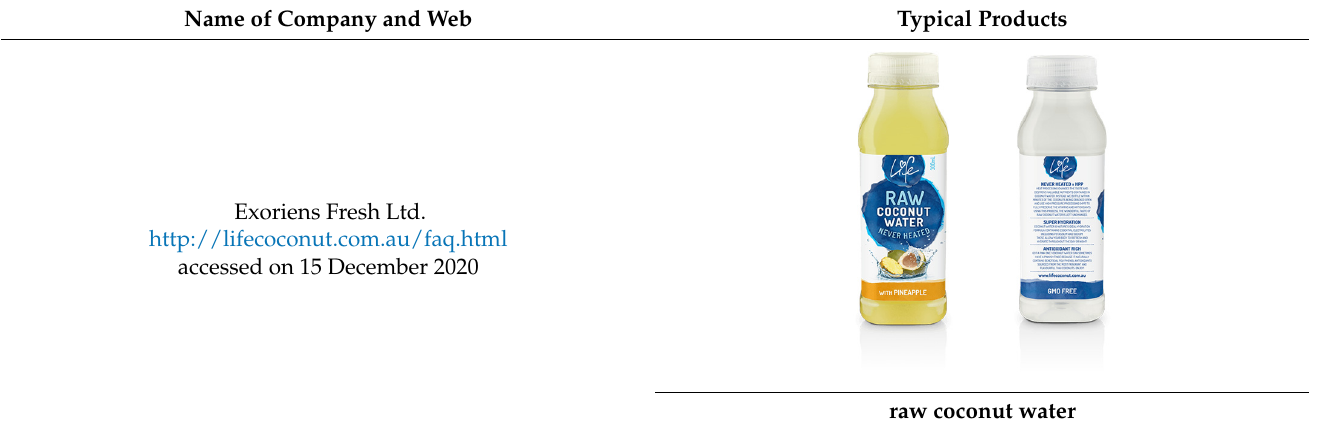
Table A16. High pressure treated products by the company Exoriens Fresh Pty Ltd.